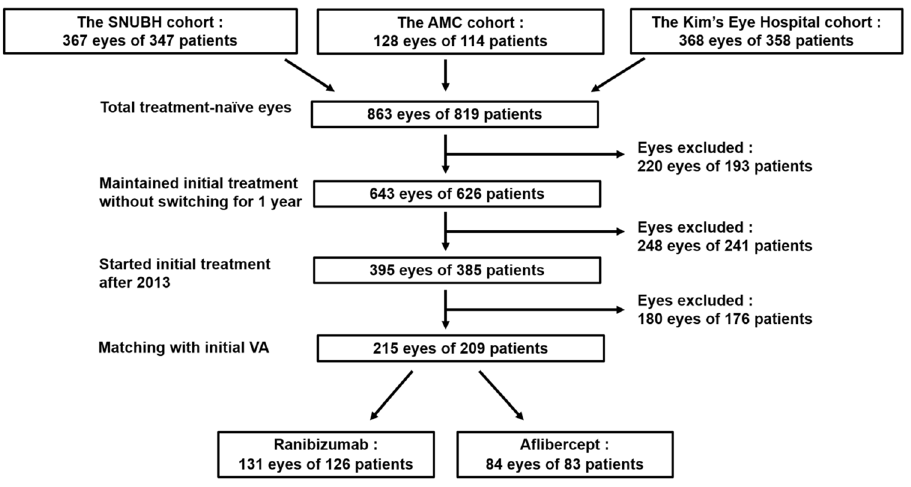
Figure 1. Flow charts of the enrolled